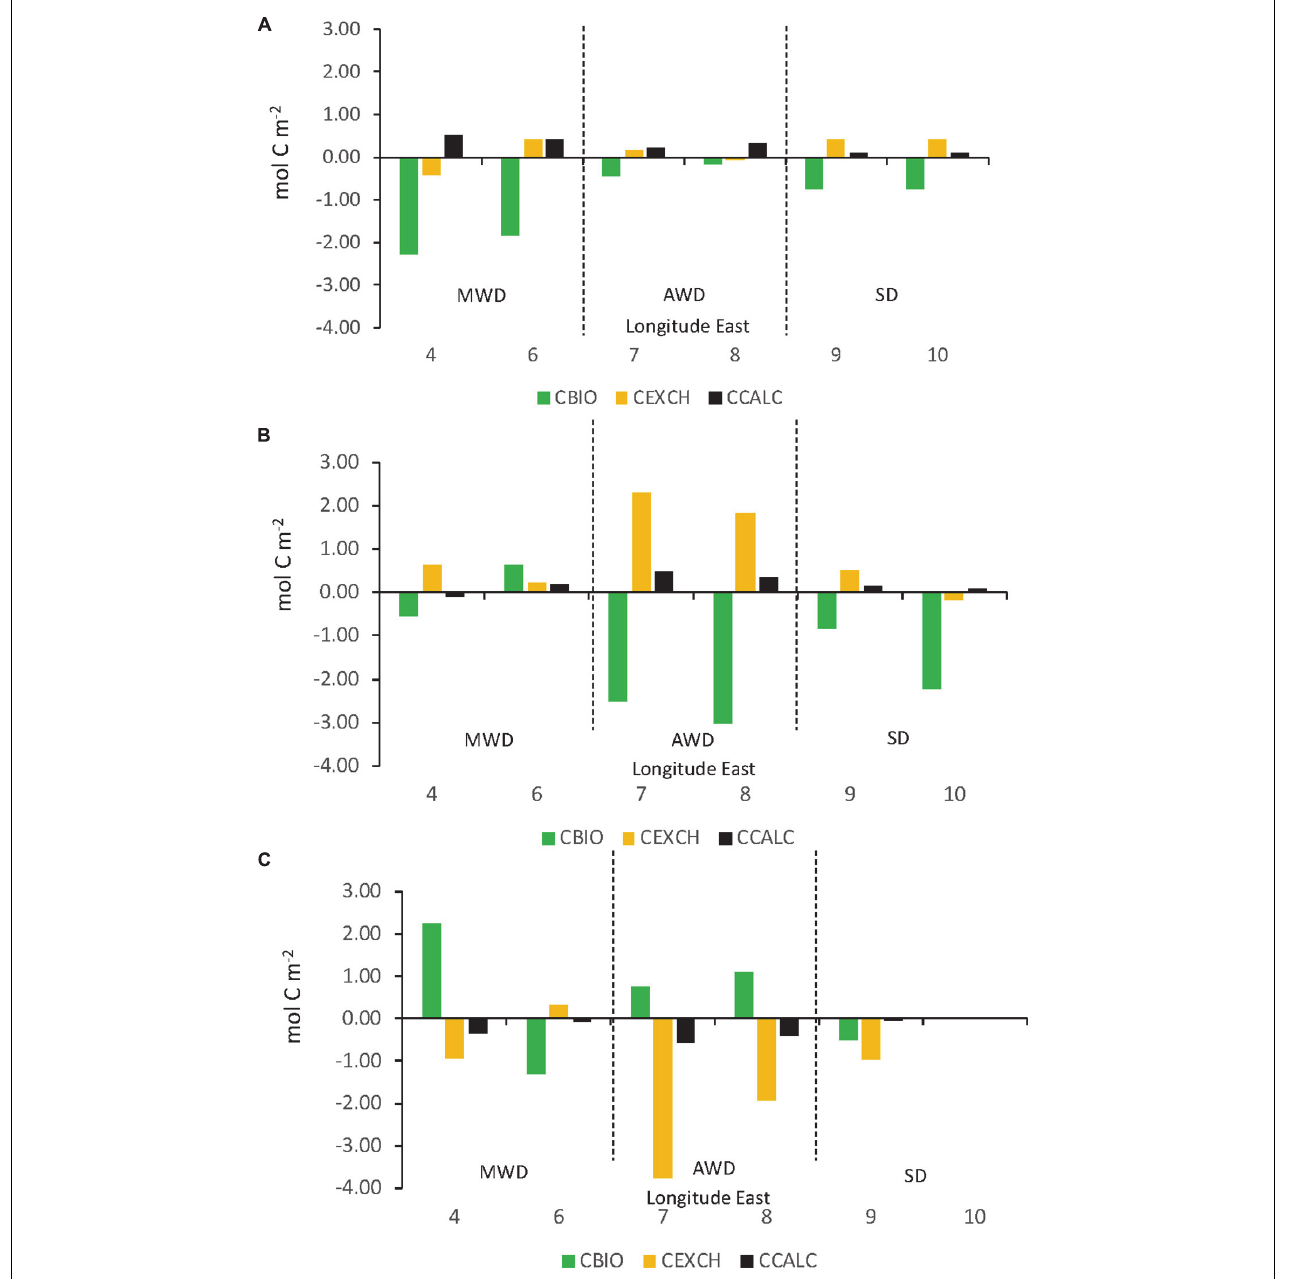
FIGURE 11 | The integrated change of C BIO (green columns), C EXCH (orange columns), and C CALC (black columns) in top 50 meters ( y -axis, mol C m − 2 ) between: (A) January and May, (B) May to August, and (C) August to end of August along the 79 ◦ N section in eastern Fram Strait ( x -axis Longitude ◦ E). The dashed vertical lines divide the section in the three domains; meltwater domain (MWD), the Atlantic water domain (AWD), and the shelf domain (SD). Positive numbers denote a gain of carbon, and negative denote a loss of